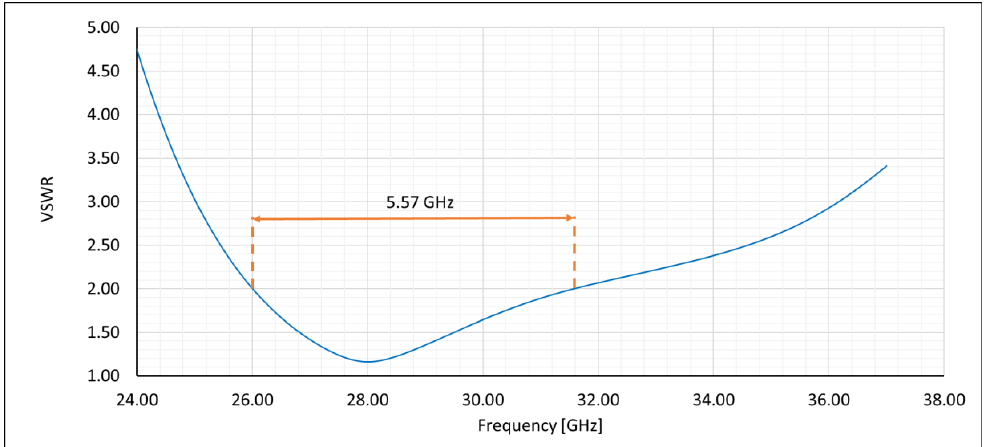
Figure 6. The chart of the voltage standing wave ratio as a function of frequency for the proposed antenna working in the 5G system.